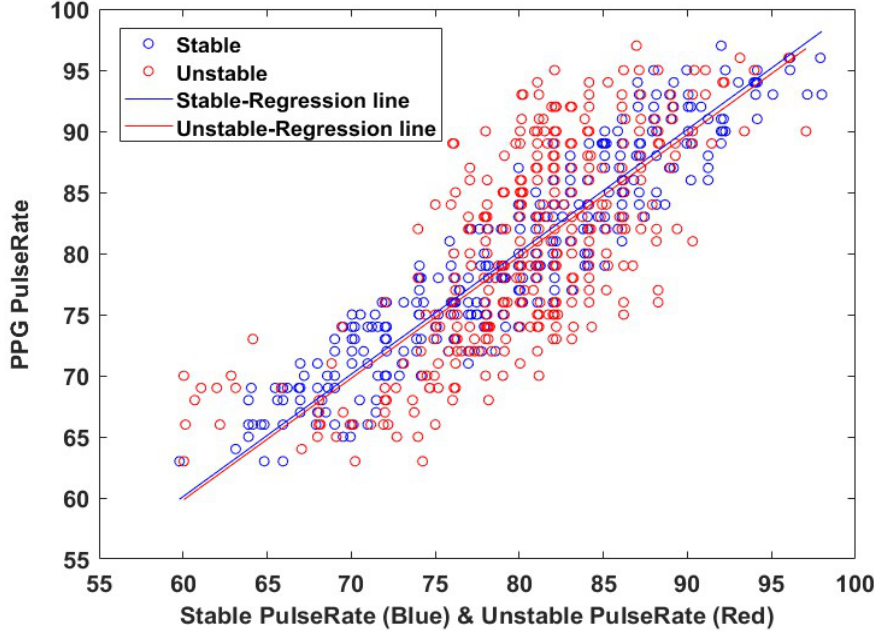
Figure 21. Comparison of FPR calculation results by stable and unstable methods.